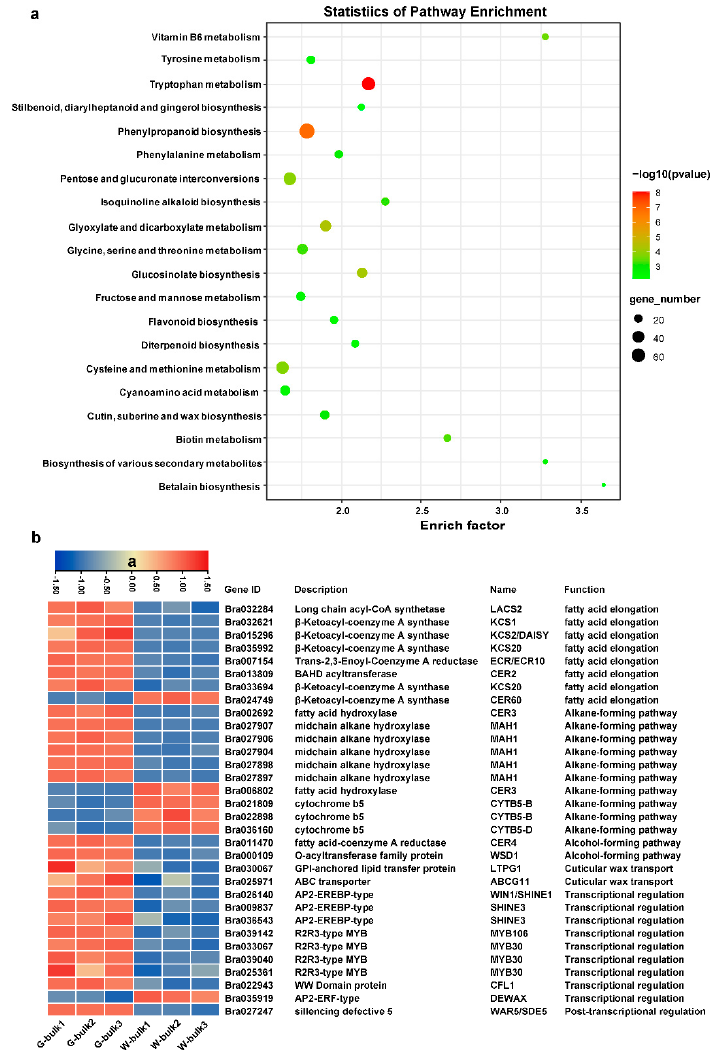
Figure 7. Transcriptome analysis in waxy and glossy stems. ( a ) Scatter plot of top 20 enriched KEGG pathways. Rich factor is the ratio of the DEG number to the background number in a certain pathway. The size of the dots represents the number of genes, and the color of the dots represents the range of the p -value. ( b ) Differentially expressed genes involved in cuticular wax metabolism. The heatmap colors are shown in log2(FPKM + 1). Three biological replicates of the W-bulk and G-bulk are